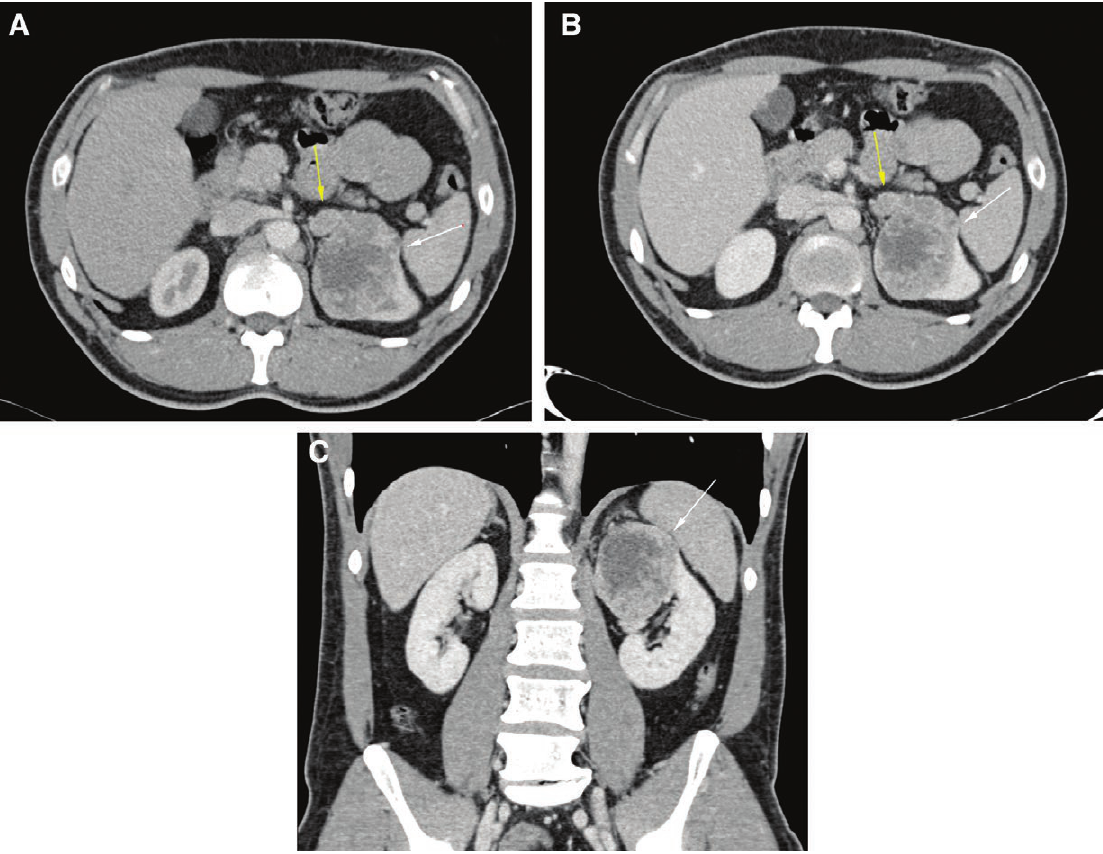
Figure 2. CT: axial scans during arterial ( A ) and venous ( B ) phases and coronal scan during venous phase ( C ) of the abdomen, show expansive lesion, partially exophytic, located in the upper pole of the left kidney (diameters 72 × 56 × 70 mm) with necrosis in the context (white arrows); it also observes repetitive lesion of the right adrenal gland body (diameter 20 mm) ( A and B ) (yellow